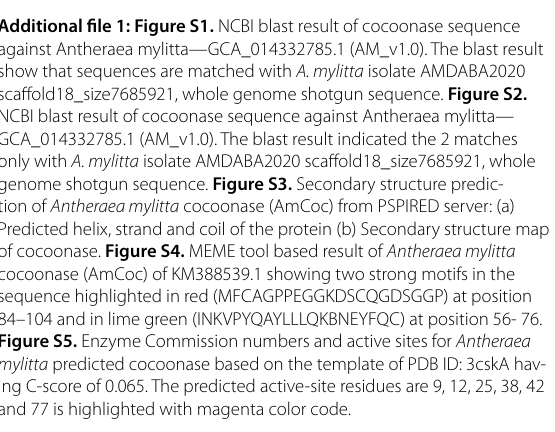
Figure S5. Enzyme Commission numbers and active sites for Antheraea mylitta predicted cocoonase based on the template of PDB ID: 3cskA hav- ing C-score of 0.065. The predicted active-site residues are 9, 12, 25, 38, 42 and 77 is highlighted with magenta color